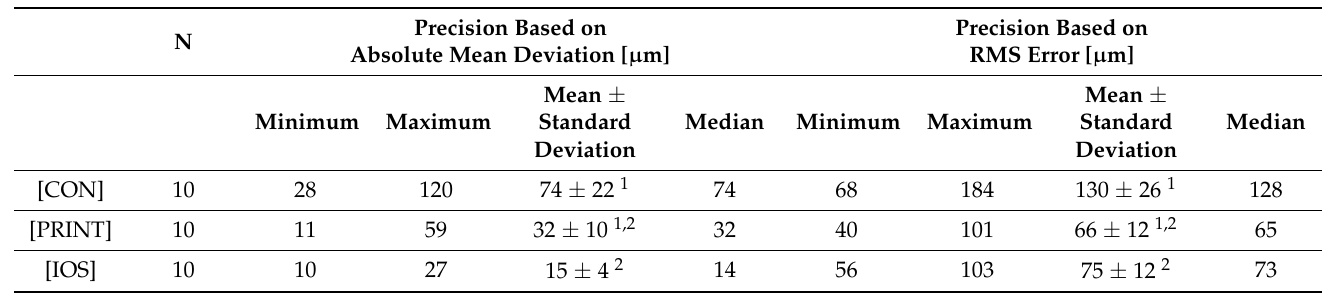
Table 4. Precision